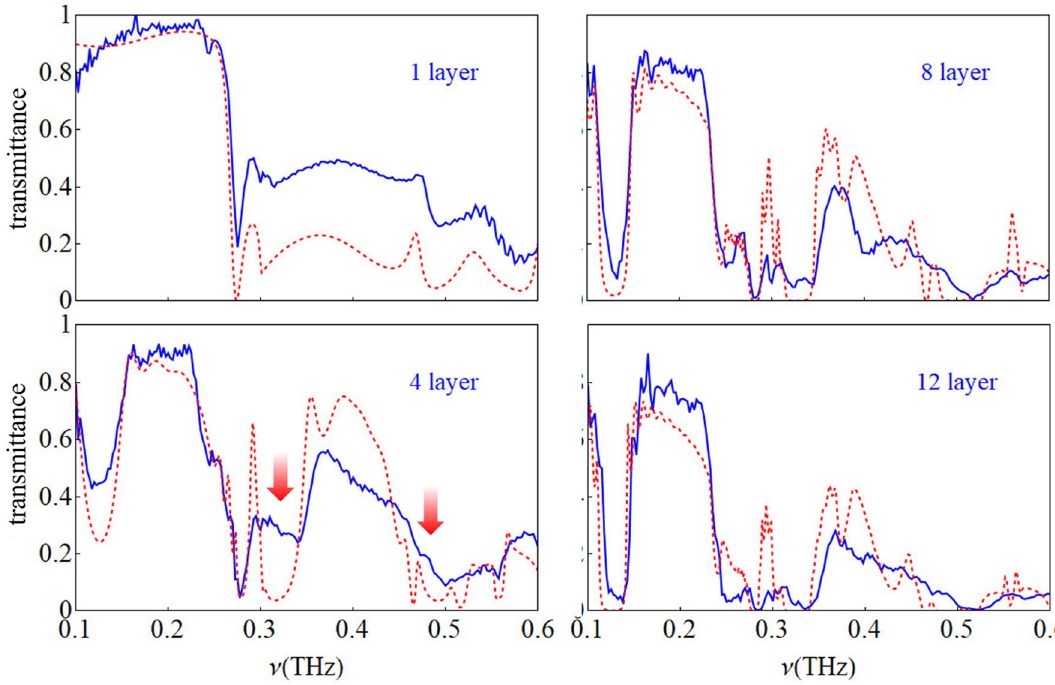
Figure 2. Comparison between experimental and simulated transmittance spectra for photonic structures made of 1, 4, 8 and 12 layers of rods. For 1 layer the agreement is very good with only an overall higher transmittance for the experimental curve after 0.3 THz. For 4, 8 and 12 layers the agreement is still good overall but differences between the experiments and simulations appear after 0.3 THz. In particular, the most evident difference is the closure of the forbidden bands which can be well seen in the structure with 4 layers (red